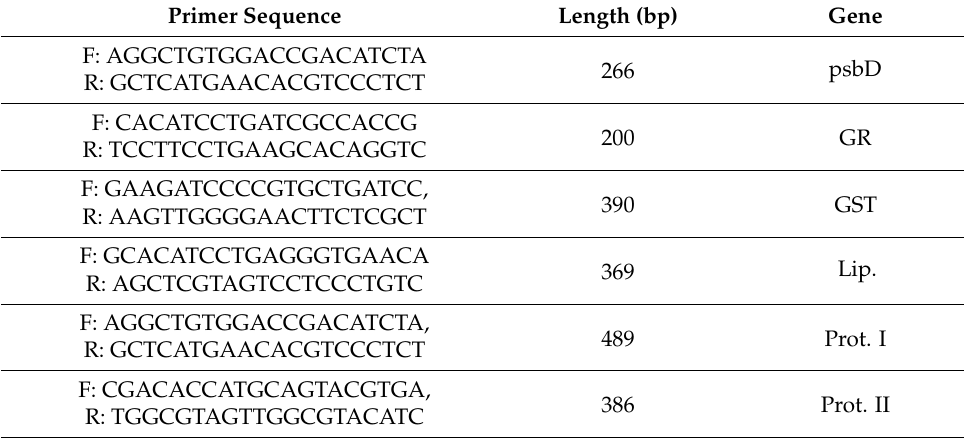
Table 5. Primers used for the cDNA amplification to detect photosystem II D2 (psbD), glutathione reductase (GR), glutathione-S-transferase (GST), lipase (Lip.), protease I (Prot. I), and protease II (Prot.